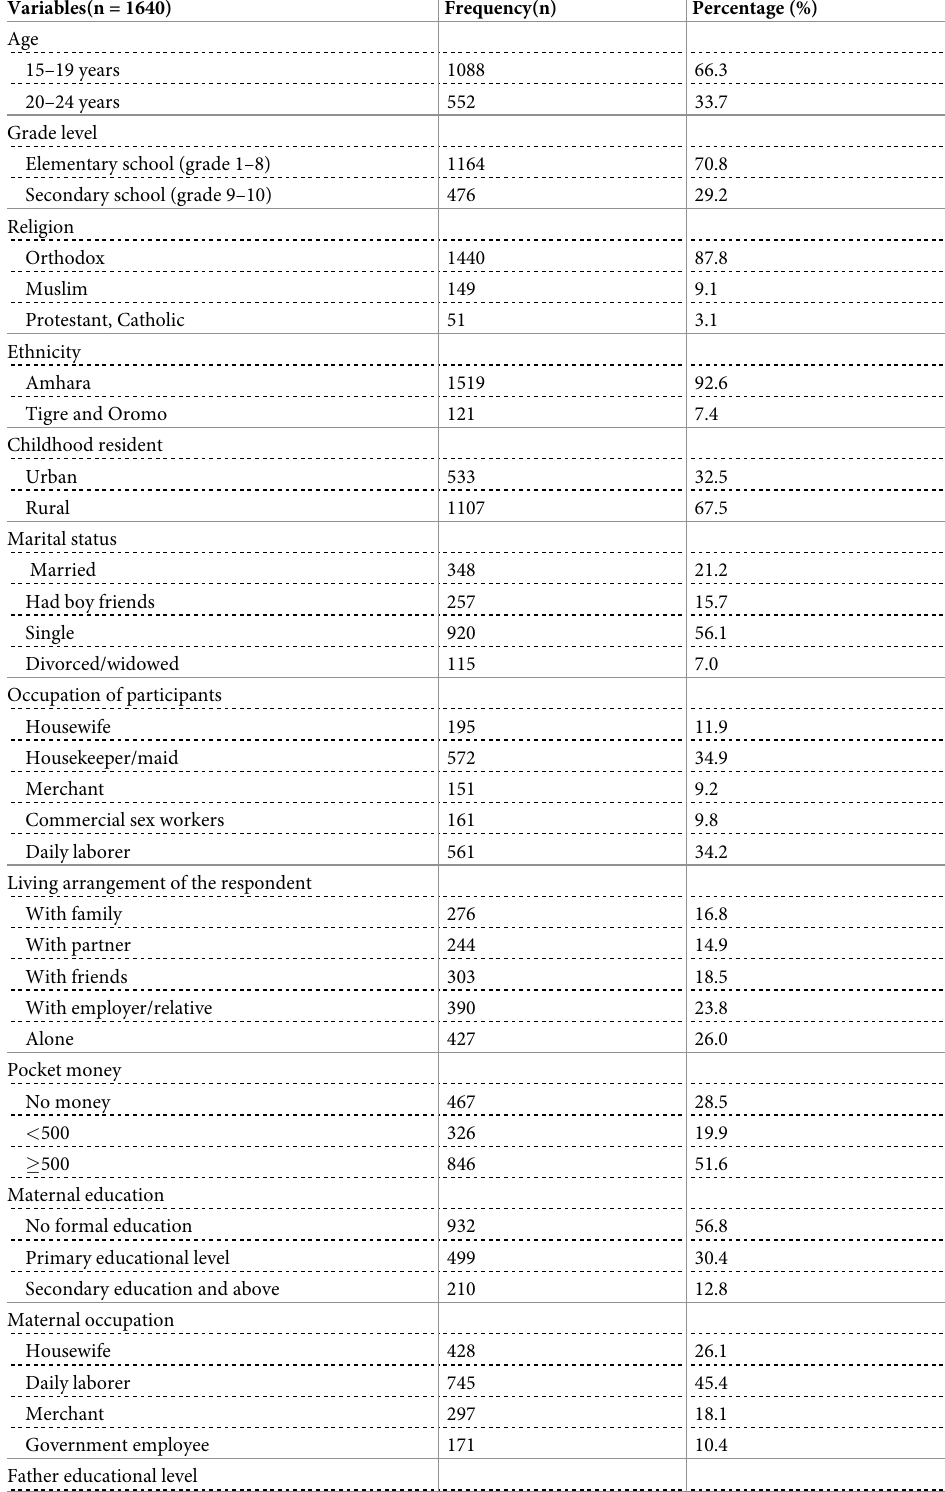
Table 1. Socio-demographic characteristic of female night students in Amhara Region, Ethiopia,